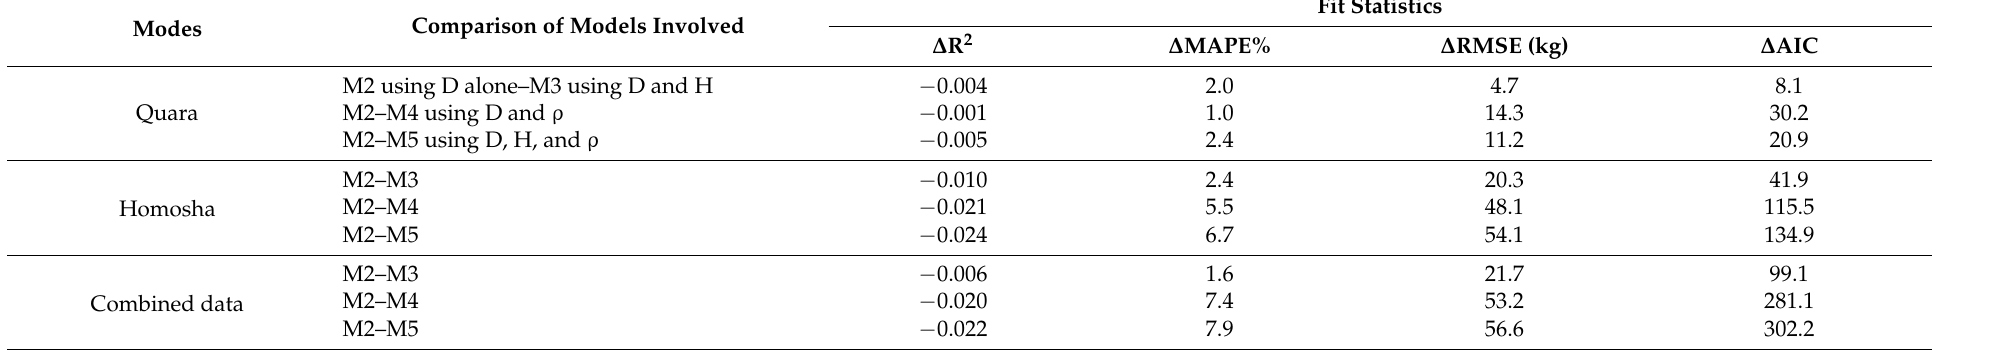
Table A3. Difference in fit statistics when models based on D alone were compared with models that used compound predictor variables (combination of predictor variables) for the mixed-species data. A negative change in R 2 ( ∆ R 2 ) indicates that the second model exhibits greater R 2 value so that the second model performed better than the first model. A positive change in the relative mean absolute error ( ∆ MAPE%), root mean square error ( ∆ RMSE in kg), and Akaike’s information criterion ( ∆ AIC) with increasing values indicates that the second model is better than the first